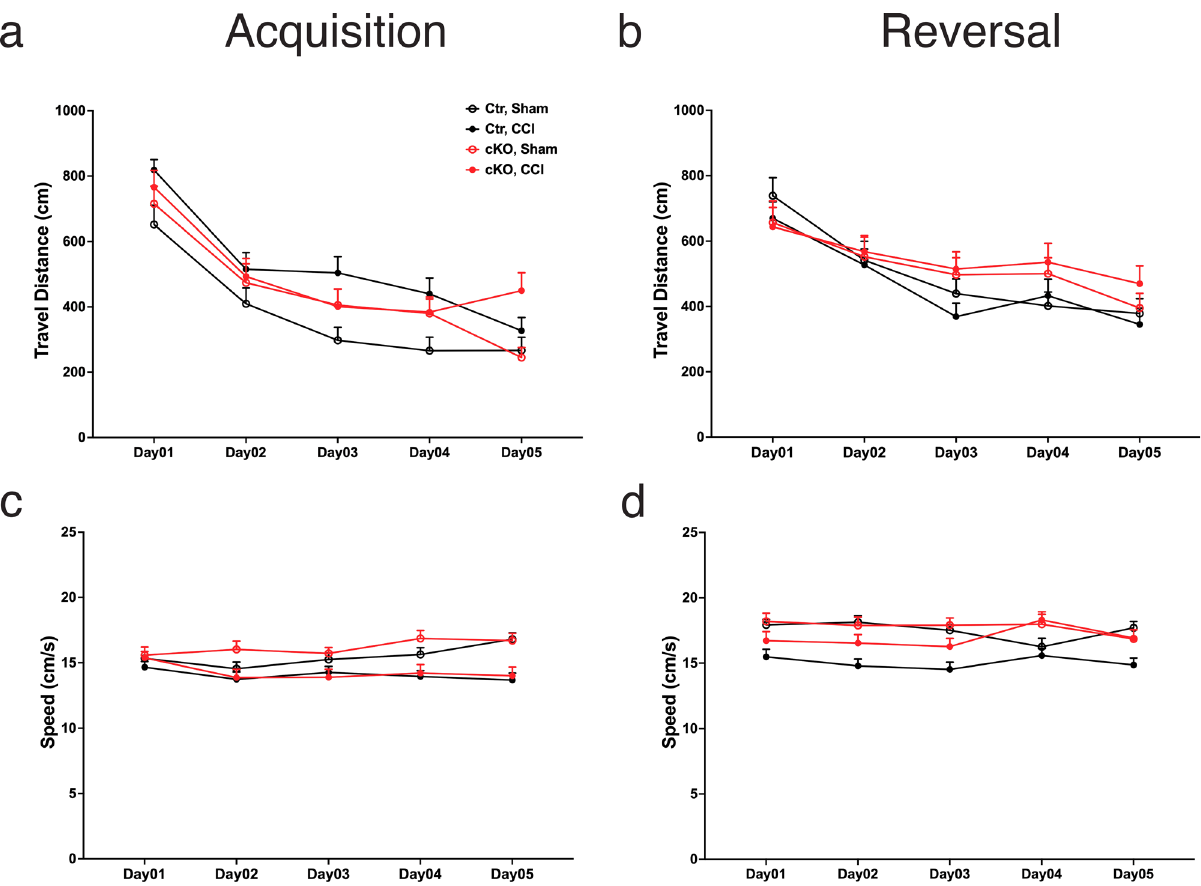
Fig. 7 Water maze speed and distance were modestly affected by CCI but not by ApoE de fi ciency. a , c During acquisition, injured mice swam longer distances to reach the hidden platform as compared to the control groups, however, there was no signi fi cant CCI effect on swim distance in mice lacking astrocytic ApoE. The injury also resulted in slower swimming speed despite the presence of astrocytic ApoE. b , d In reversal learning trials, all mice swam similar distance to reach the new position of the platform. Interestingly, the swimming speed was slower in Ctr – CCI group. However, there was no difference observed between cKO-Sham and cKO – CCI. Data are presented as means ±